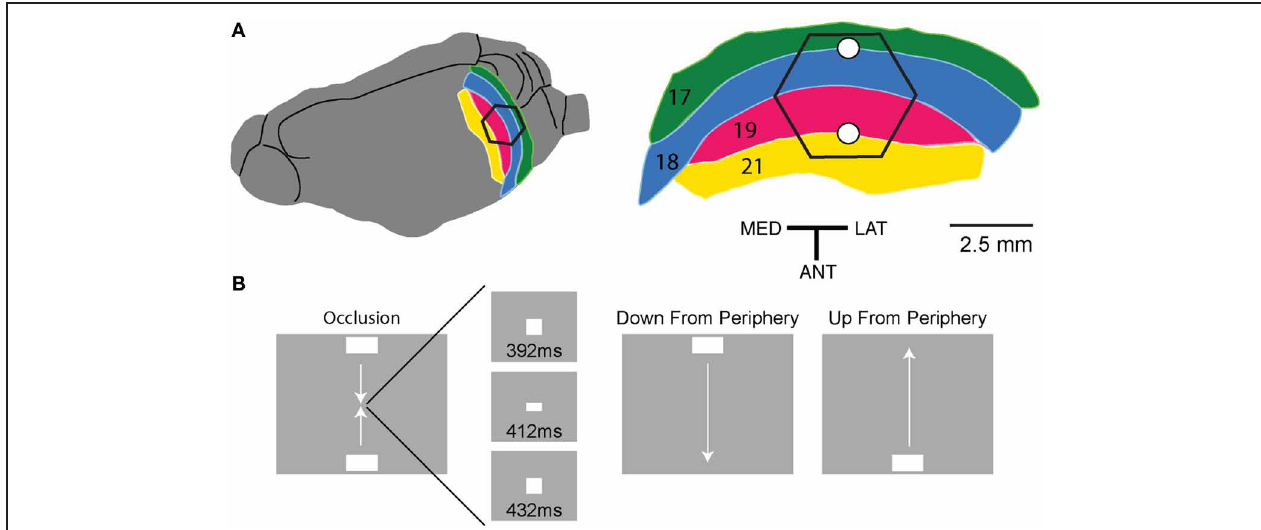
FIGURE 1 | Experimental conditions and ferret visual areas. (A) The left hemisphere of the ferret brain with visual areas 17, 18, 19, and 21. The cortex monitored by the hexagonal photodiode array is delimited in black. The cytoarchitectural borders between areas 17 and 18 and between areas 19 and 21 correspond to the mapping of the vertical meridian in the field of view on the cortex. The two white dots mark the expected mappings of the center of field of view. The relation